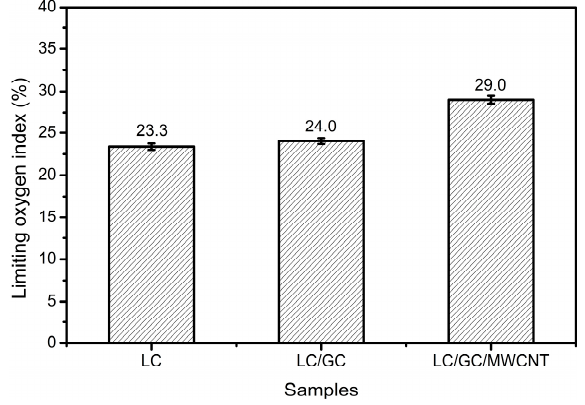
Figure 8. Limiting oxygen index of LC composite, LC/GC composite, LC/GC/MWCNT composite.